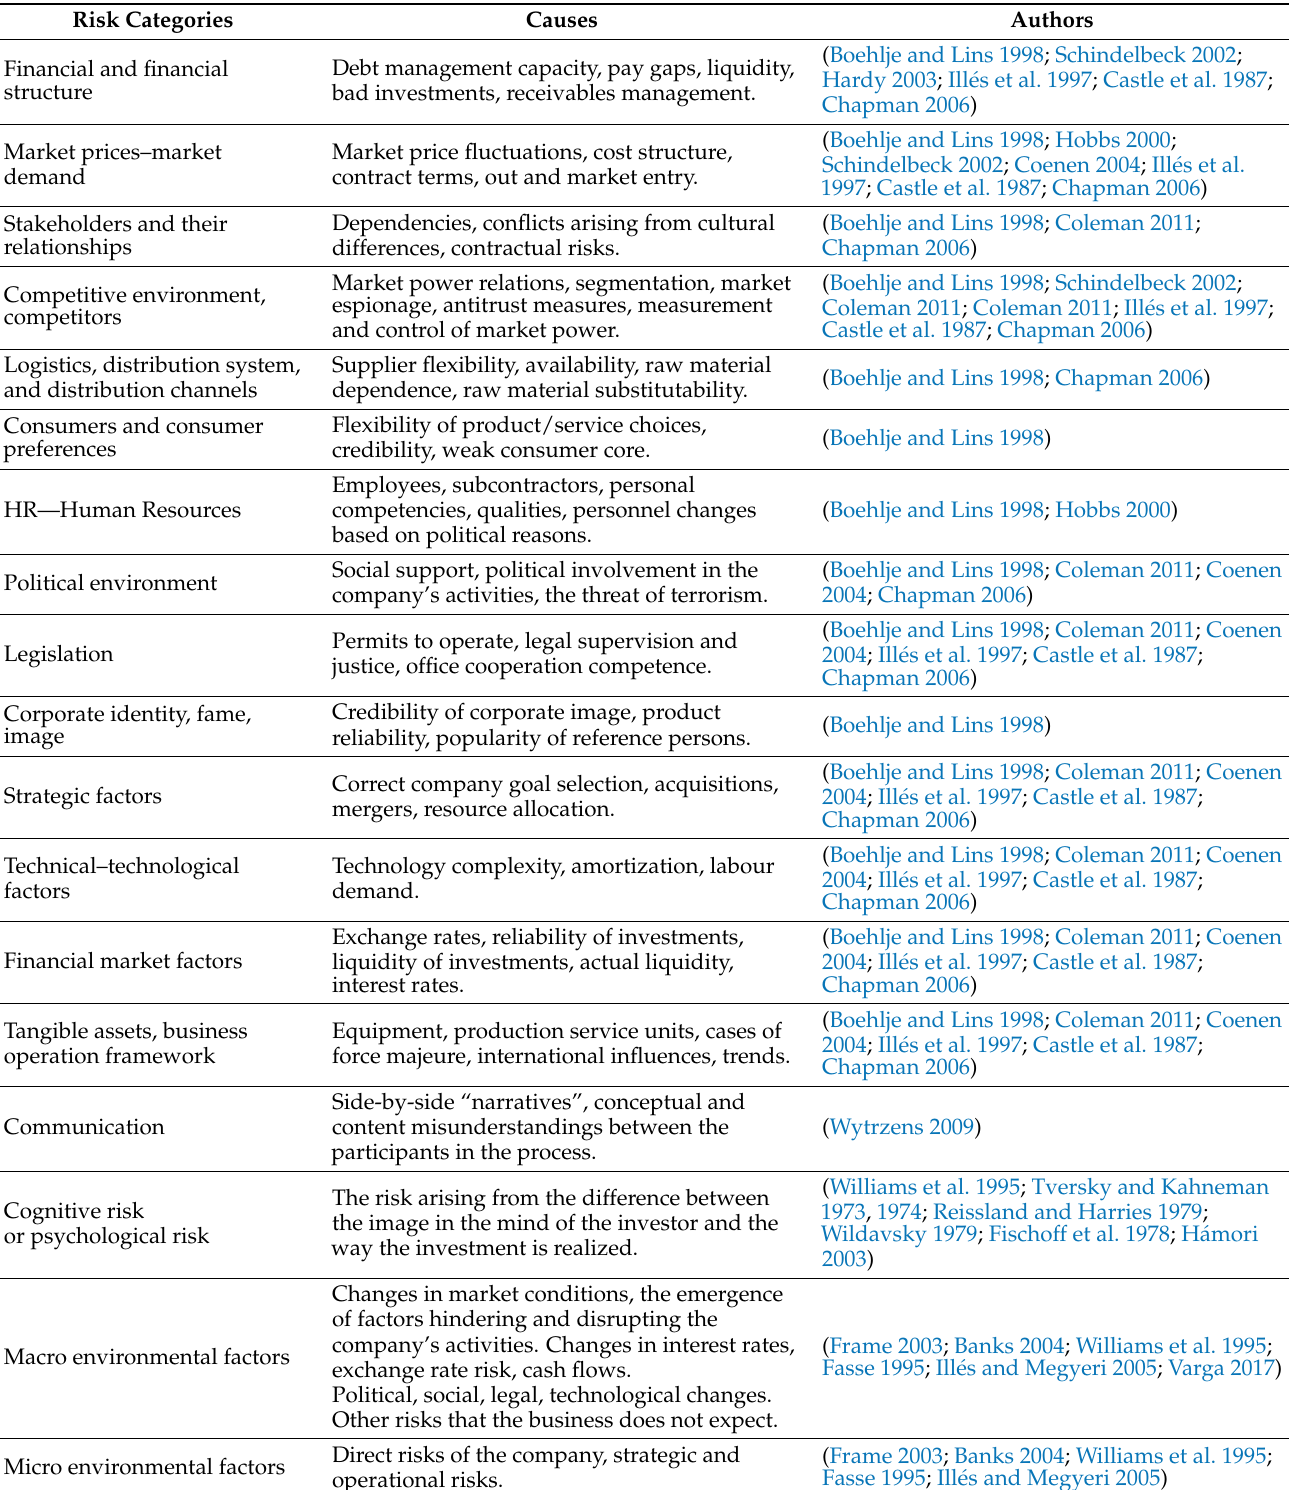
Table 2. Risk categories and their causes according to the authors. Source: Boehlje and Lins 1998, supplemented by secondary resources and with own empirical